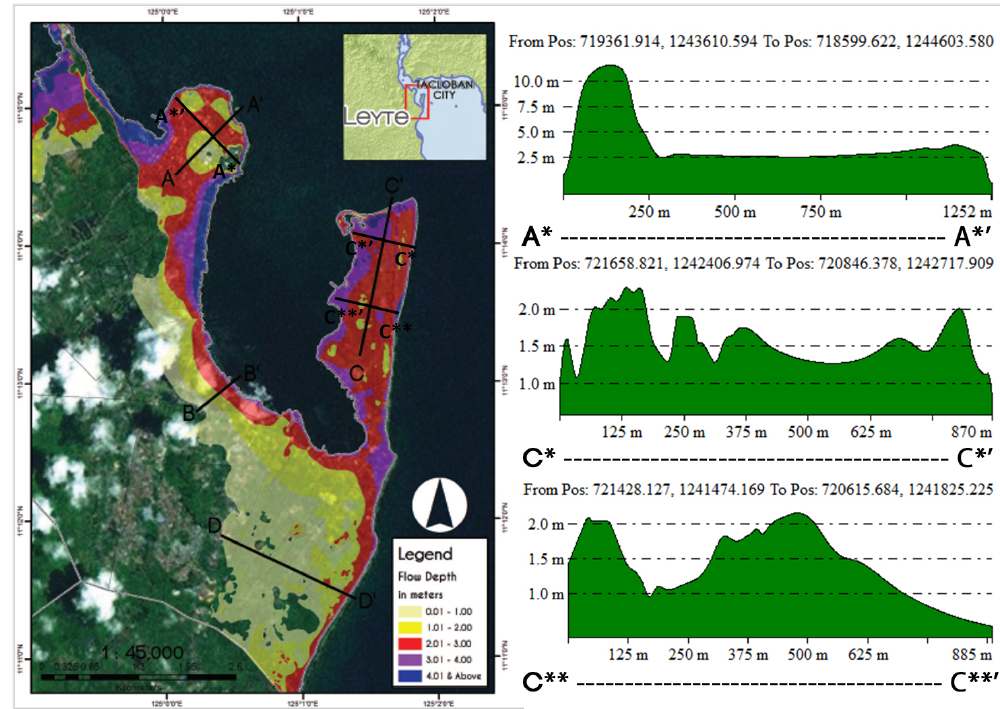
Figure 8. Leyte inundation map with topographic elevation profiles at the marked transects (variable y axis scale to clearly display the local variation in